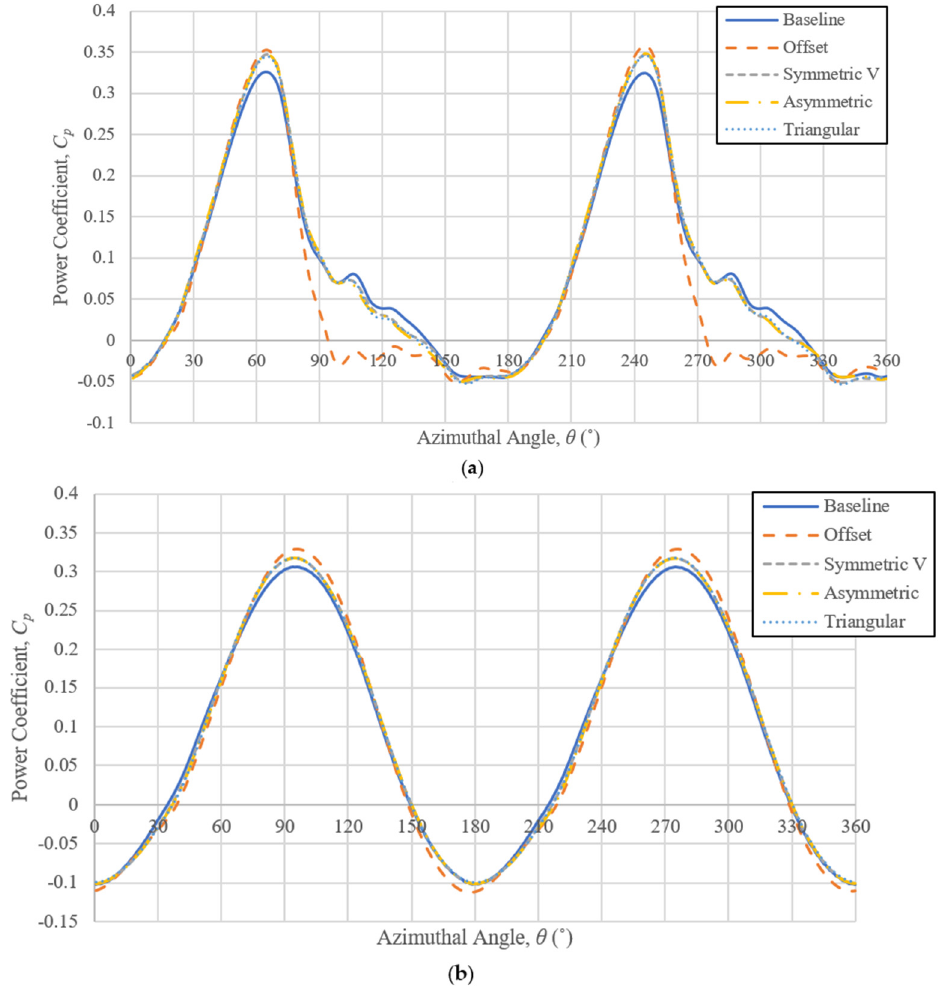
Figure 7. Overall C P vs. azimuthal angle at ( a ) TSR 1 and ( b ) TSR 2.